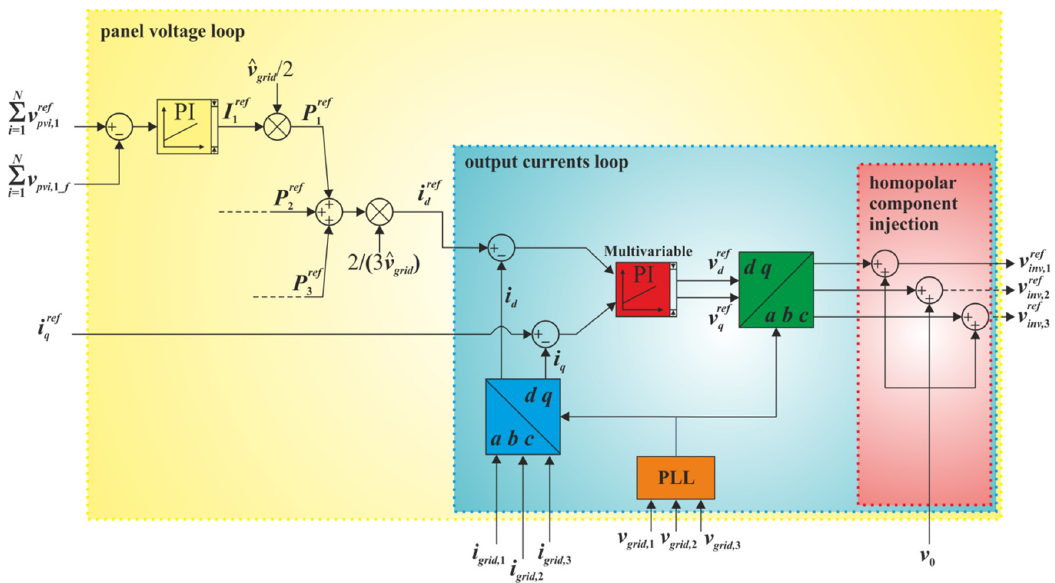
Figure 2. Control scheme. PLL: phase ‐ locked loop circuit. PI: Proportional Integral.